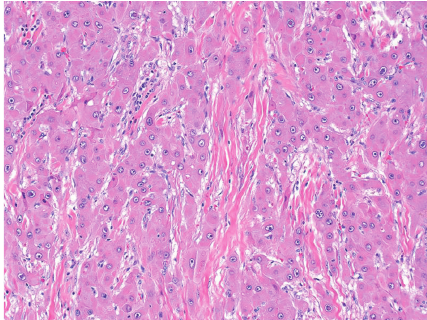
F 3: �riginal magni�cation 64�. �n area of glandular-type differentiation with mucin production is